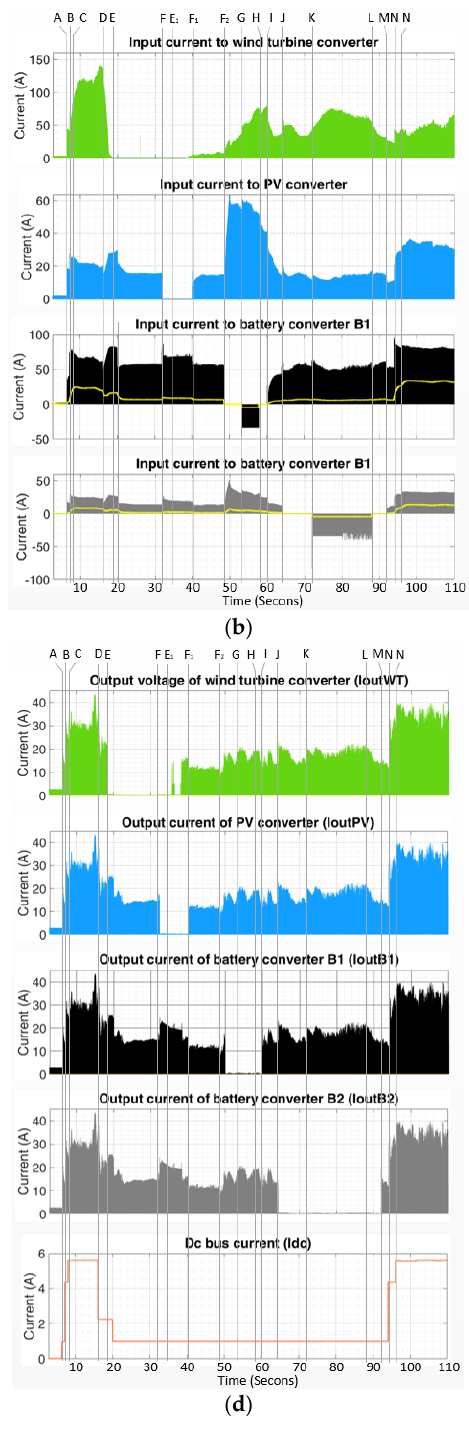
Figure 6. Simulation model obtained results. ( a ) Voltages in the sources; ( b ) Currents in the converters’ inputs; ( c ) Voltages in the converters’ outputs and V dc ; ( d ) Currents in the converters’ outputs and I dc .